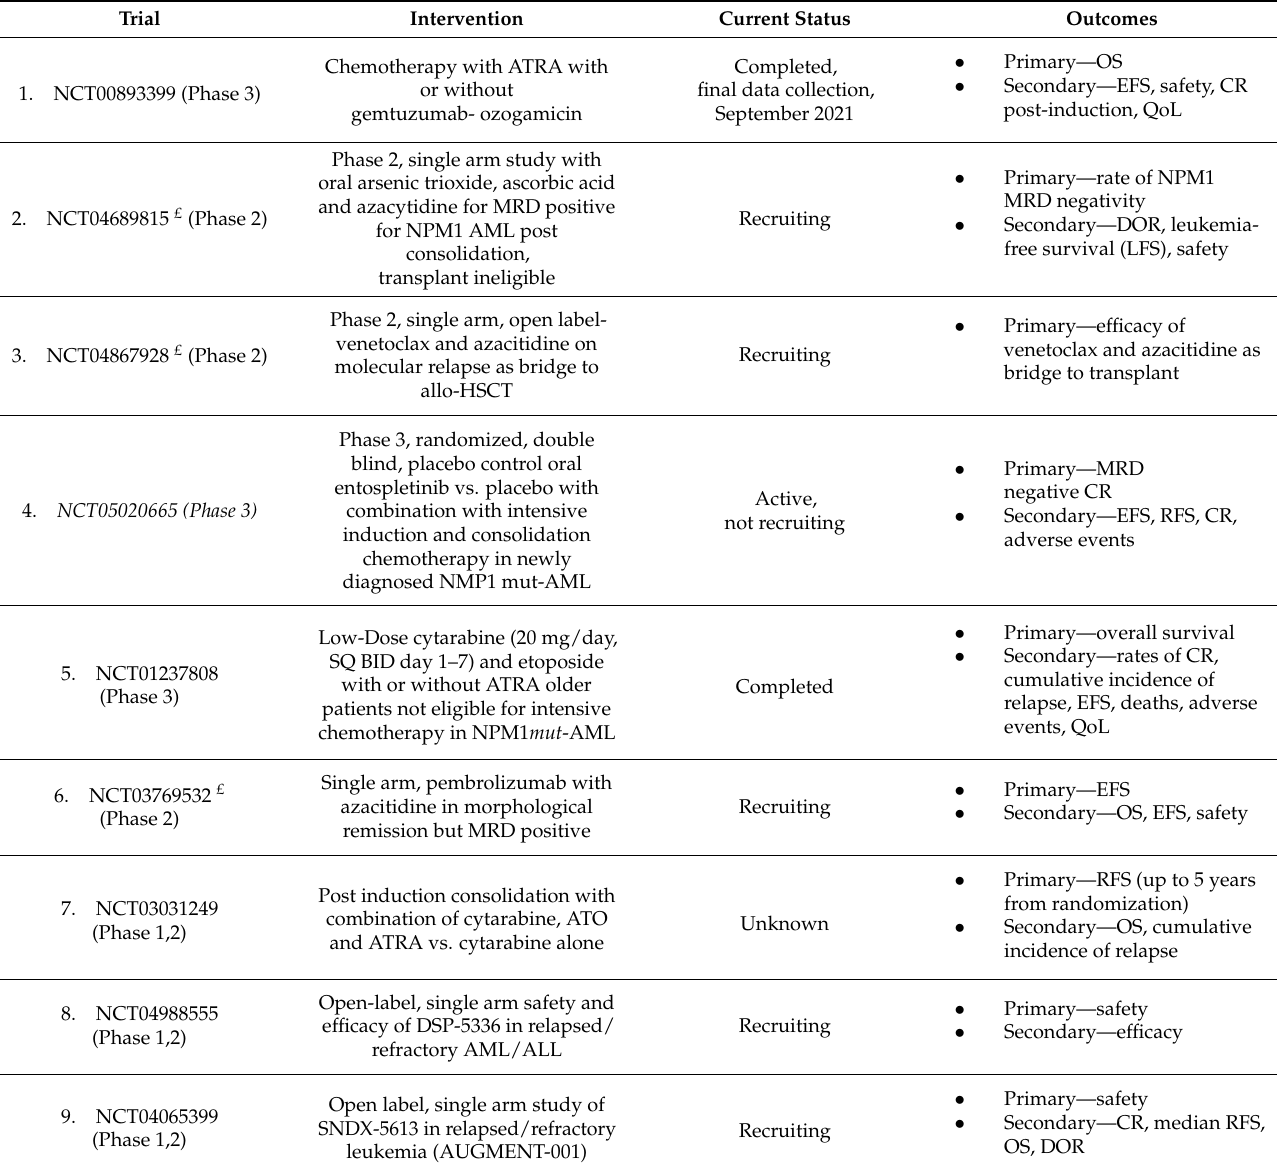
Table 1. List of ongoing phase 1/2 and 3 trials in NPM1 mut -AML (£: trials exploring pre-emptive treatment on molecular relapse) (date accessed-January 7, 2023) (ref.